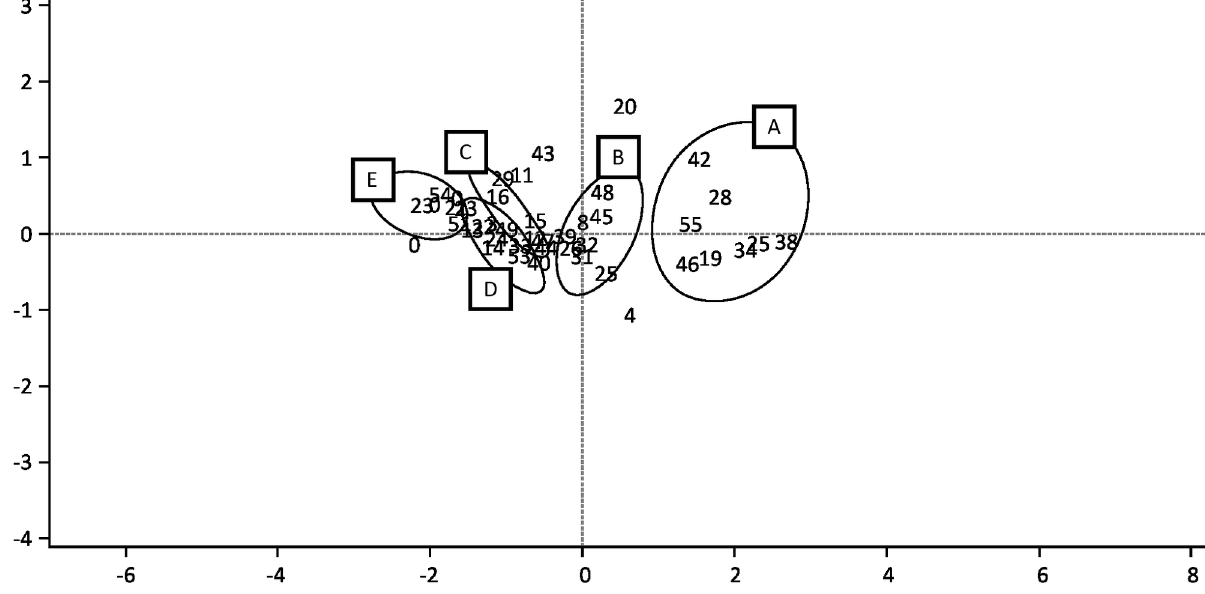
Figure 3. Detrended Correspondence Analysis (DCA) ordination diagram of plots for species composition in fields with different abandonment decades and intact forests. (A = forests; B = 1940s and 1950s plots; C = 1960s; D = 1970s and 1980s; E = 1990s). (n = 55)